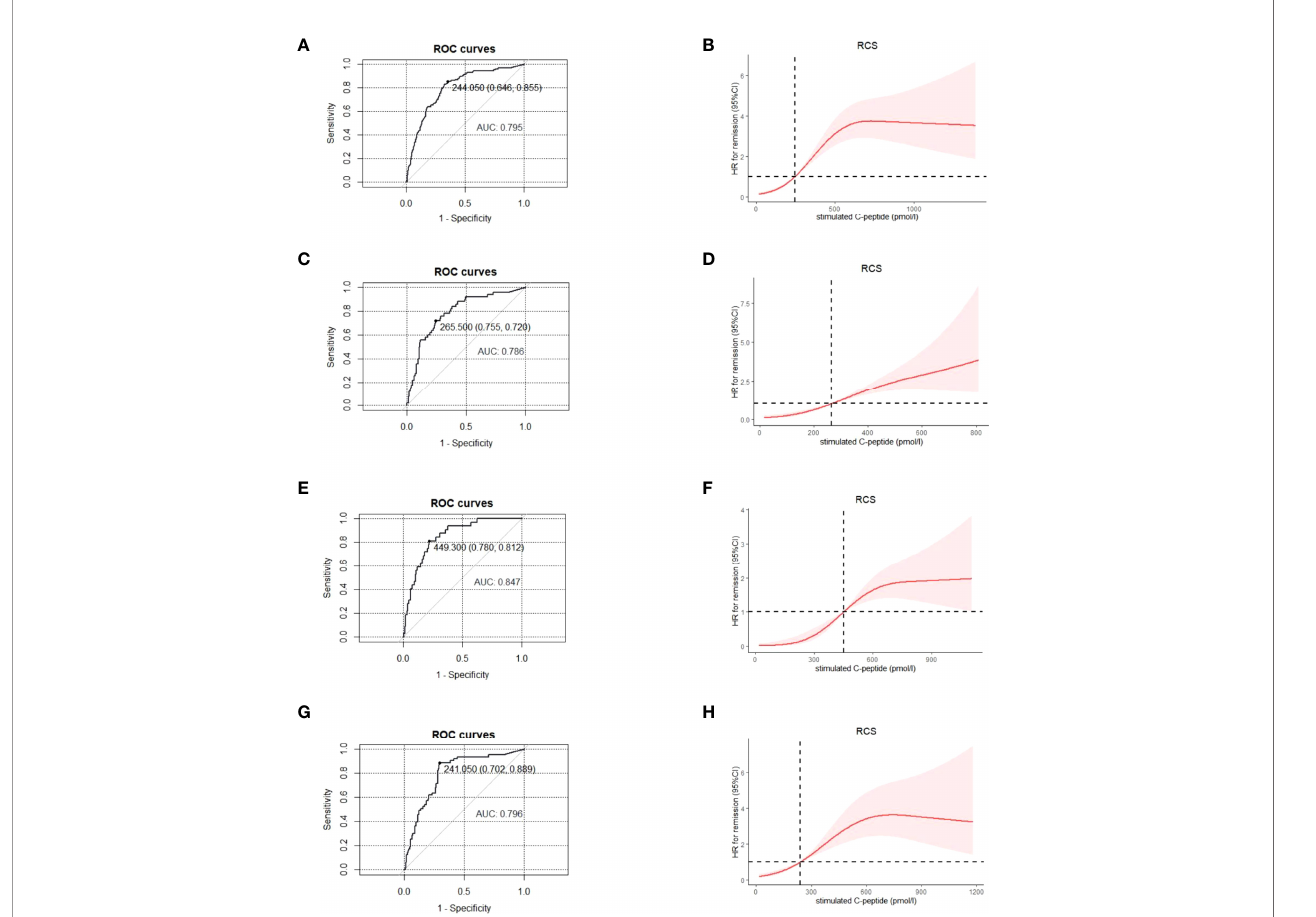
FIGURE 3 | For patients of different age- groups, ROC and RCS curves were used to fi nd the optimal cut-off point for stimulated C-peptide to de fi ne the partial remission, with GA ≤ 23% and insulin dose ≤ 0.5 u/kg/day being the diagnostic criteria. All age- groups: ROC (A) , RCS (B) ; ≤ 12 years group, ROC (C) , RCS (D) ; 12- 18 years group, ROC (E) , RCS (F) ; ≥ 18 years group, ROC (G) , RCS (H) . ROC, receiver operating characteristic; RCS, restricted cubic spline; GA, glycated